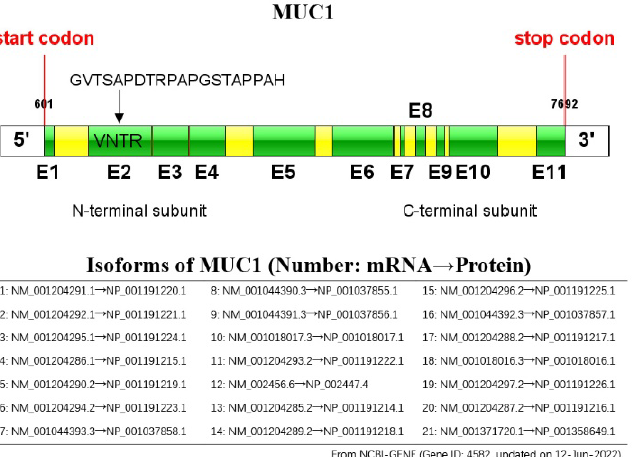
Figure 1. Schematic representation of the MUC1 gene: the MUC1 gene consists of 11 exons (E1 to E11, indicated by green colored boxes), and has 21 isoforms.